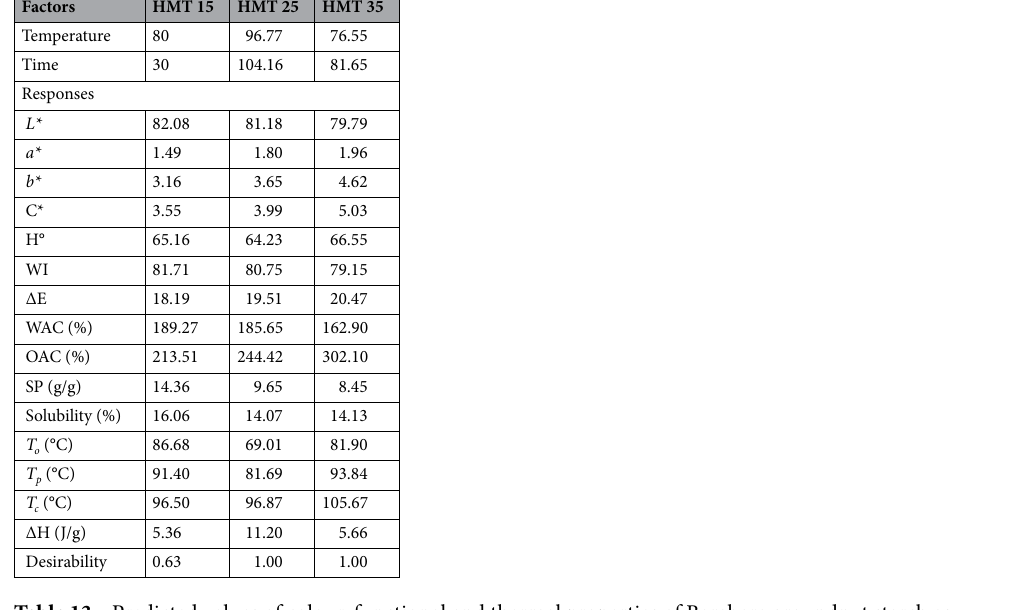
Table 13. Predicted values of colour, functional and thermal properties of Bambara groundnut starch as affected by heat and moisture treatment. WAC: water absorption capacity; OAC: oil absorption capacity; SP: swelling power; ∆H: gelatinization enthalpy; ∆E: colour difference, WI: whiteness index; L* : lightness/ whiteness; a* : yellowness/redness; b* : blueness/greenness; C*: chroma; H°: hue; T o : onset temperature; T p : peak temperature; T c : concluding temperature; ∆H: gelatinization